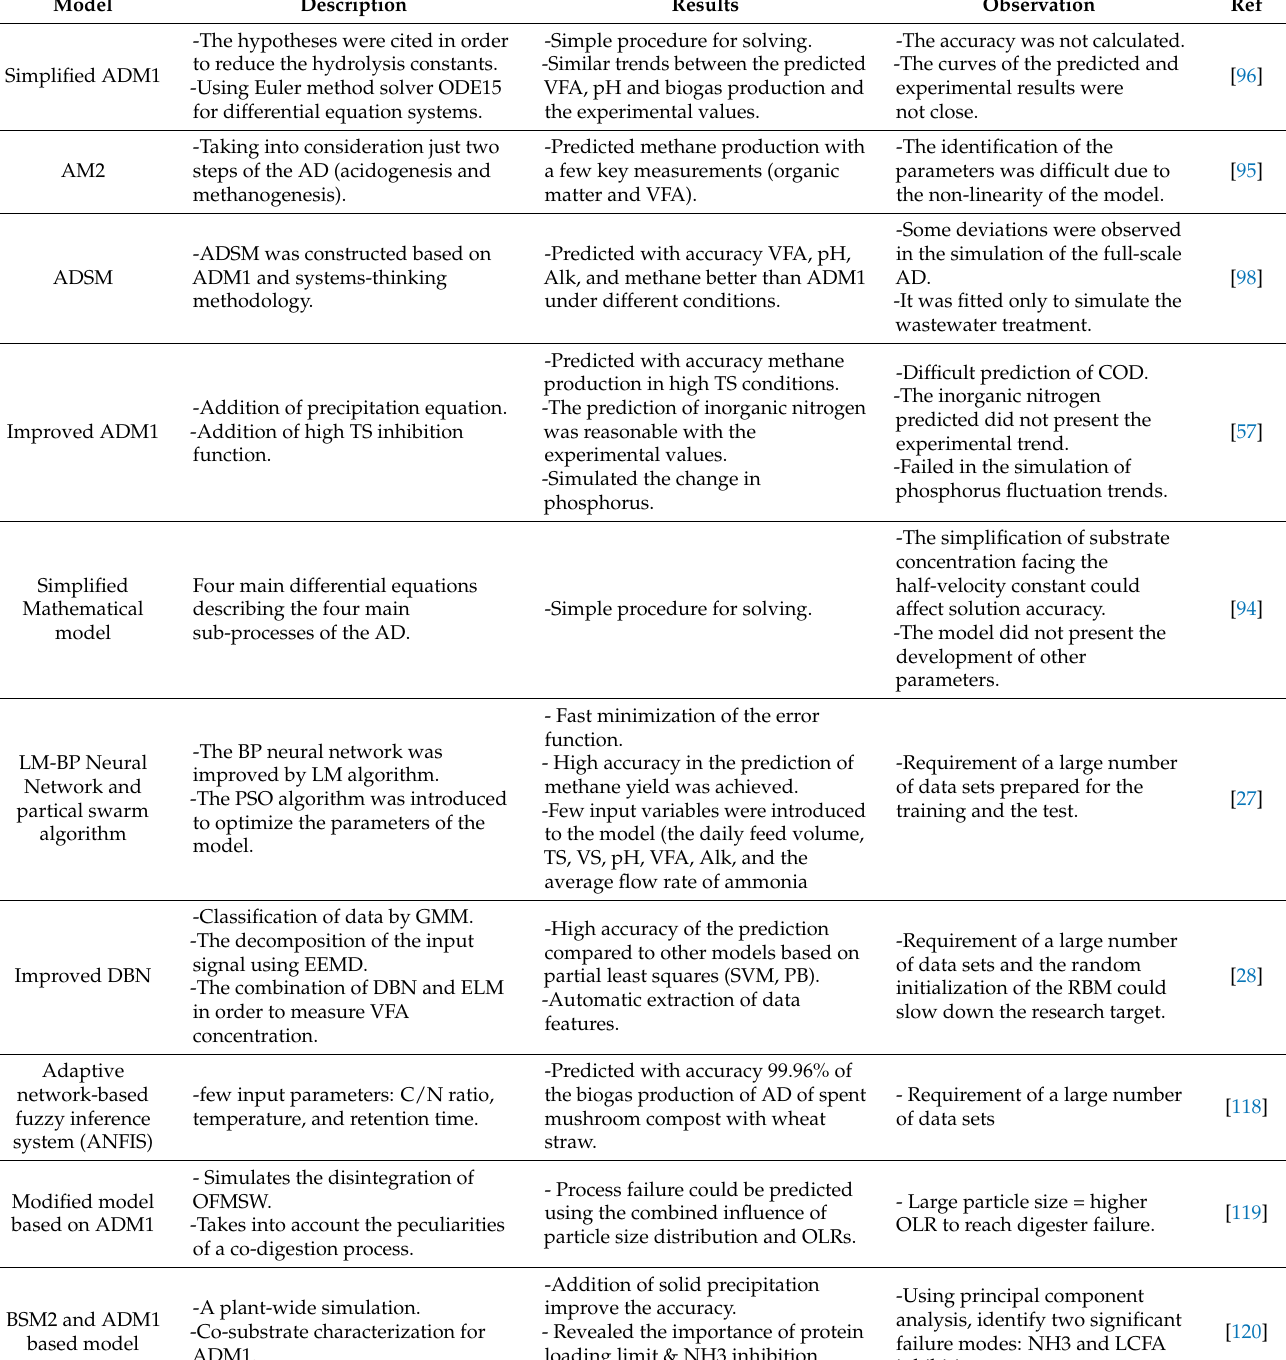
Table 3. Discussion of different mathematical